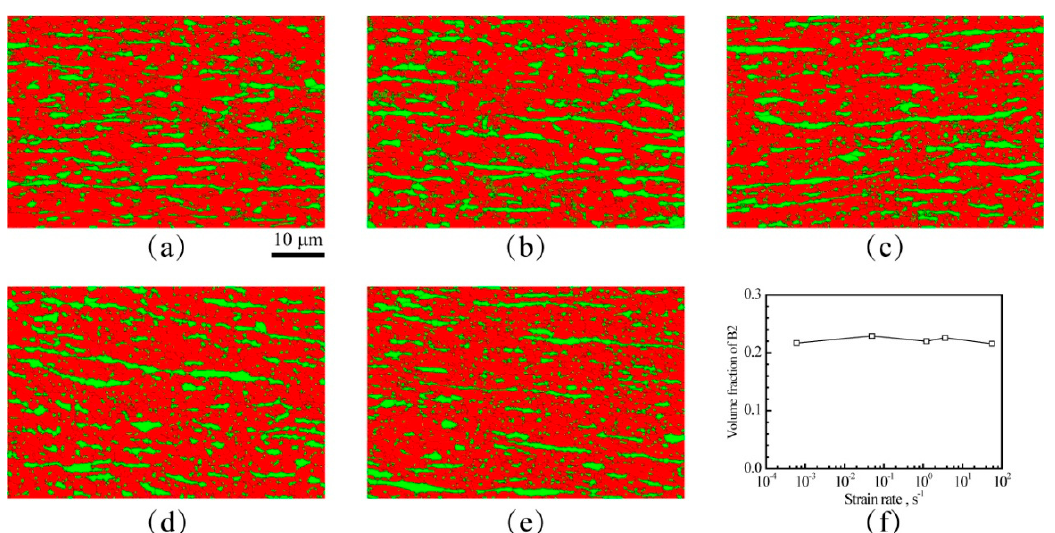
Figure 6. EBSD phase distributions after testing at strain rate of ( a ) 0.0006/s; ( b ) 0.05/s; ( c ) 1.2/s; ( d ) 3.6/s; ( e ) 56/s. The red color stands for γ -austenite phase, and the green color stands for B2 phase. ( f ) The volume fraction of B2 phase after tensile testing versus the applied tensile strain rate.